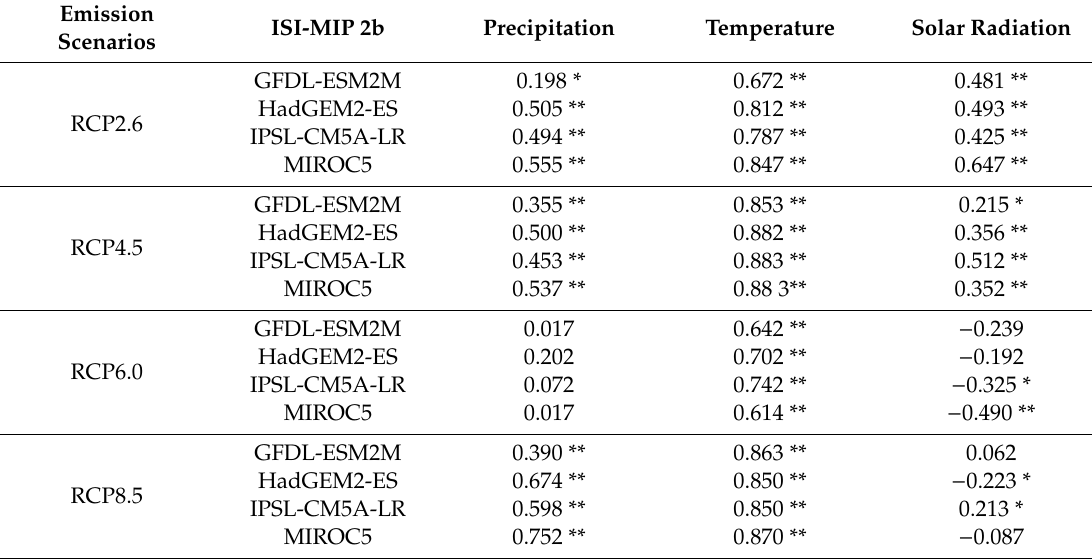
Table 3. Correlation of precipitation, temperature, solar radiation, and